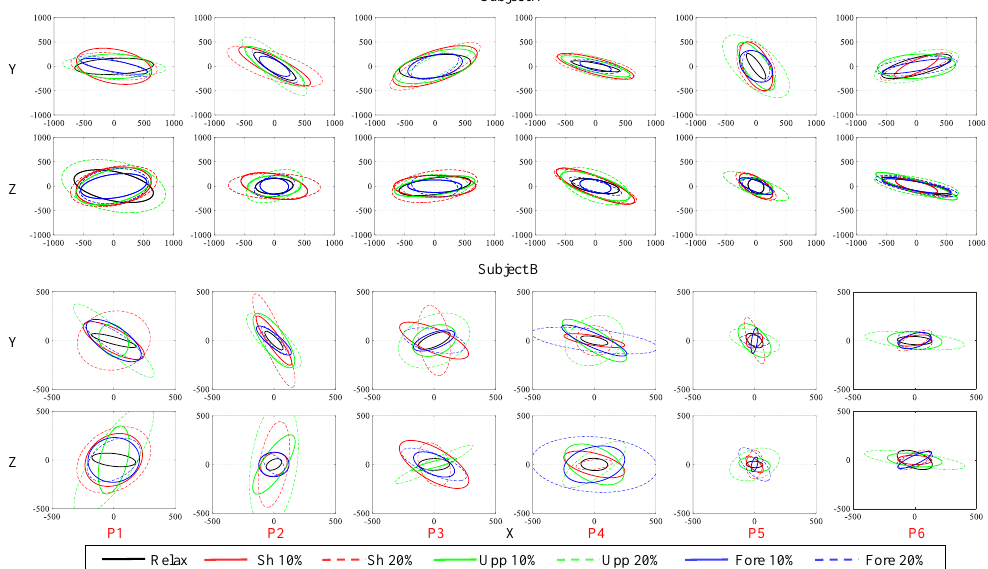
Figure 6. The estimated Cartesian stiffness ellipsoids of subjects A and B (typical results across subjects) in different arm configurations and muscle co-contraction states. P# represents an individual arm pose, and the different colors in the subplot represent different muscle co-contraction states, as shown in the bottom